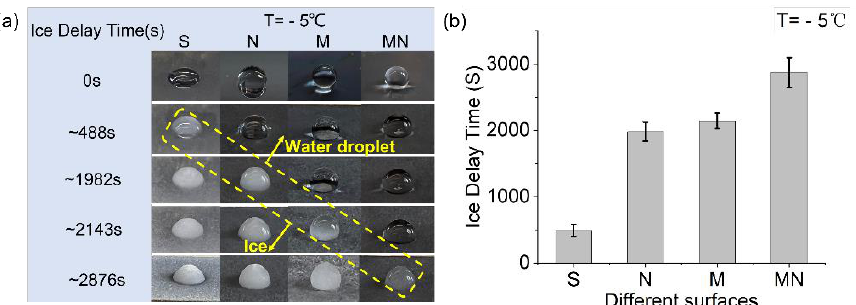
Figure 7. ( a ) Observations of ice formation on different surfaces at − 5 °C. From left to right are the photos of the droplets on the surfaces of S, N, M, and MN, respectively. First, the droplet on the S surface freezes, with an IDT of ~488 s; the droplets on M and N surfaces freeze at ~1982 s and 2143 s; and the droplet on MN freezes at ~2876 s. ( b ) Comparison of the icing delay times of water droplets on four different surfaces.